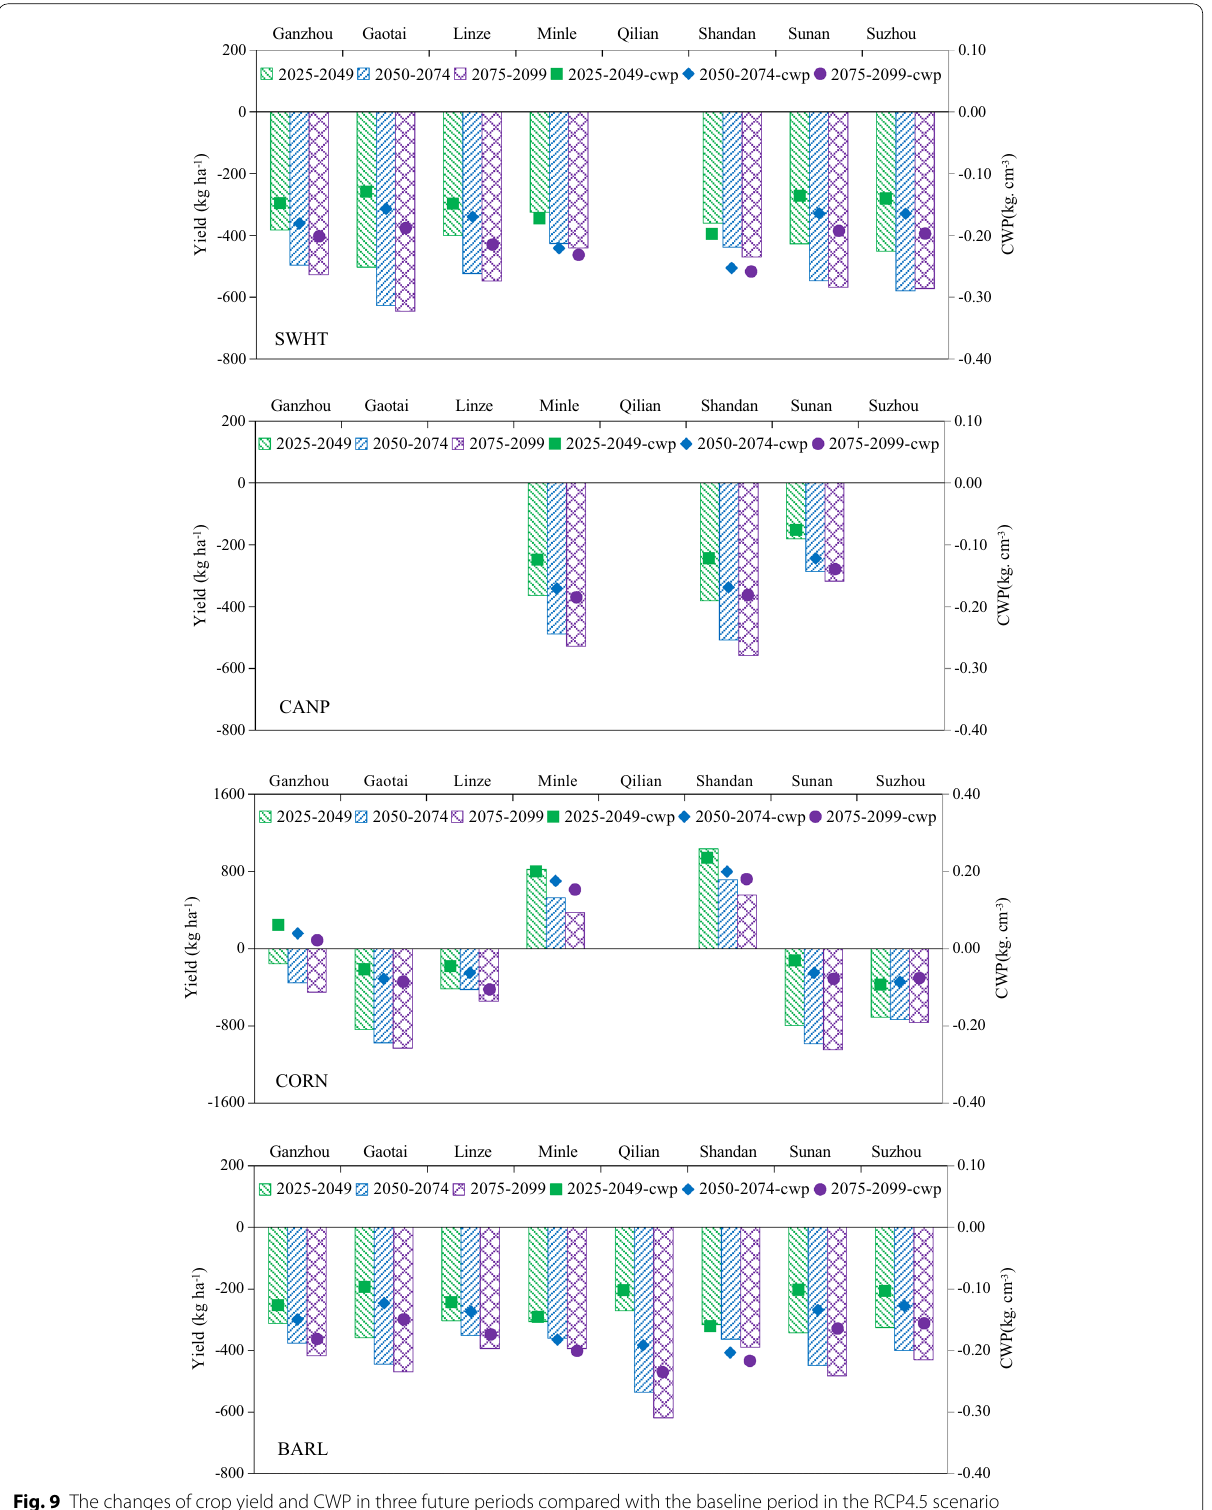
Fig. 9 The changes of crop yield and CWP in three future periods compared with the baseline period in the RCP4.5 scenario